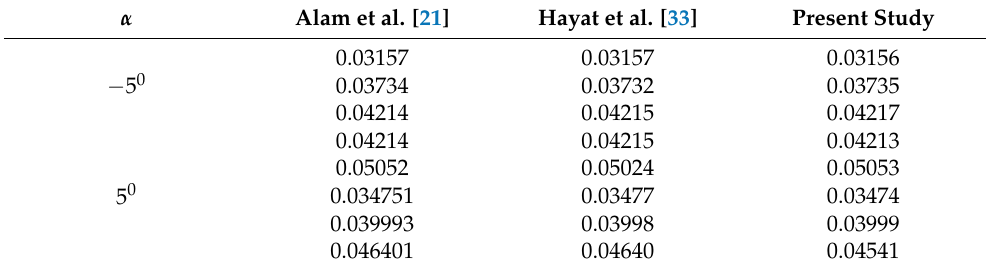
Table 3. Comparison of numerical values of − 1/ α β _ η (1) against multiples values of an opening angle ψ , when Re = 50, Pr = 3.0, Nb = 0.4, Nt = 0.2, Γ = 0, or n = 1, M = 0. α Alam et al.